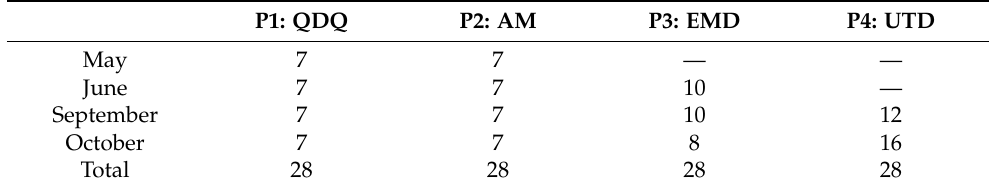
Table 1. No. of episodes analysed of each news podcast selected as a